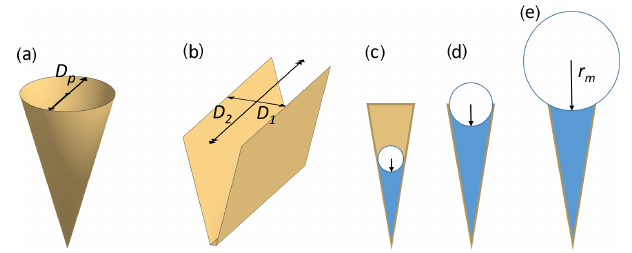
Figure 2. Illustration of pore shapes and pore filling: panel (a) shows an empty conical pore with diameter D p and panel (b) an empty wedge-shaped pore with a width D 1 and a length D 2 = ∞ . Panels (c) to (e) show pore condensation with increasing radius of the meniscus for a conical or wedge-shaped pore assuming complete wetting ( θ ws = 0 ◦ ). The radius of meniscus in a coni- cal or cylindrical pore is denoted r m and the radius of meniscus in a wedge-shaped pore or trench is denoted r 1 = D 1 / 2, while r 2 = D 2 = ∞ (not